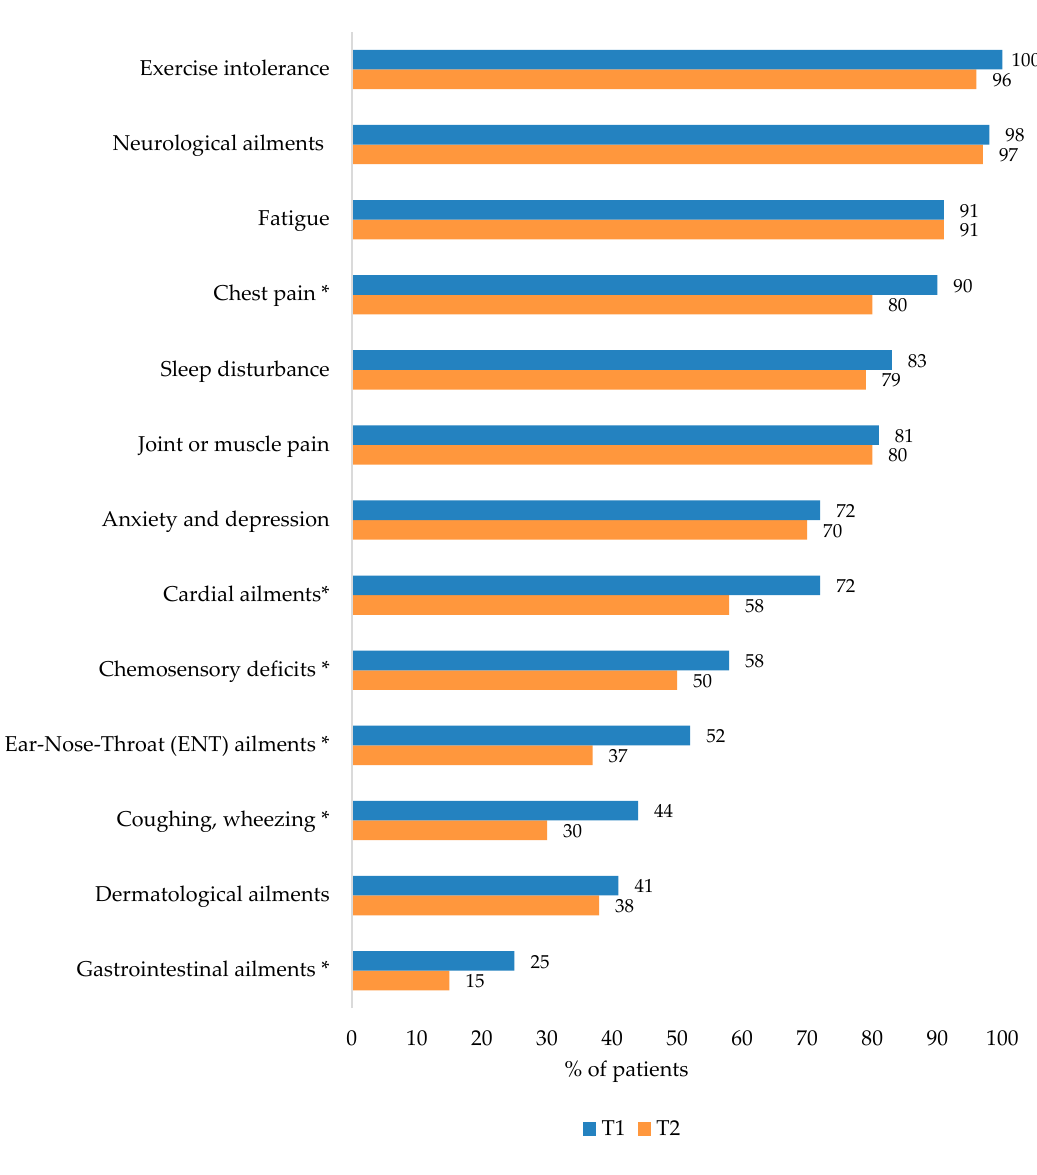
Figure 1. Summarized symptom clusters of post-COVID patients before (T1, blue) and after (T2, orange) rehabilitation. Significant differences are marked with * ( p < 0.05).